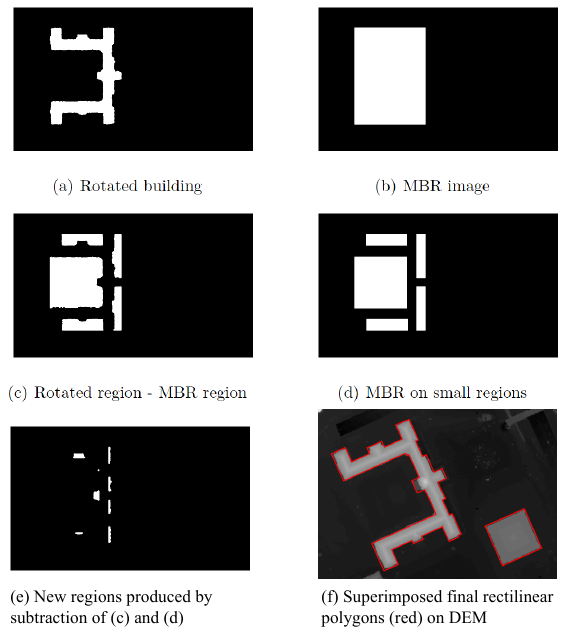
Figure 5: MBR based polygon approximation rotated back to original orientation (Fig. 5(f)). In this figure the red lines highlight the rectangular polygons.